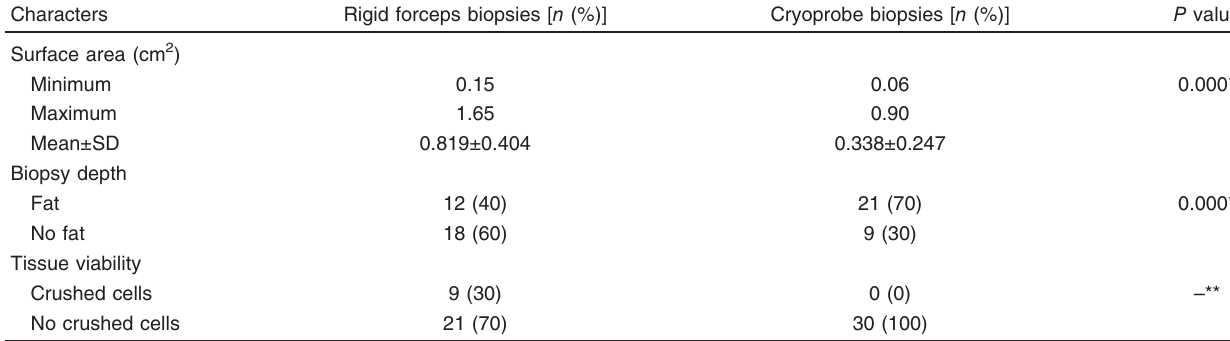
Table 2 Comparison between rigid forceps and cryoprobe biopsies ( N = 30 patients) Characters Rigid forceps biopsies [ n (%)] Cryoprobe biopsies [ n